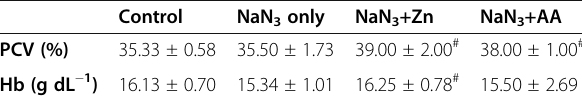
Values are given as mean ± standard deviation for groups of seven rats each. Significant differences: # p < 0.05 versus NaN 3